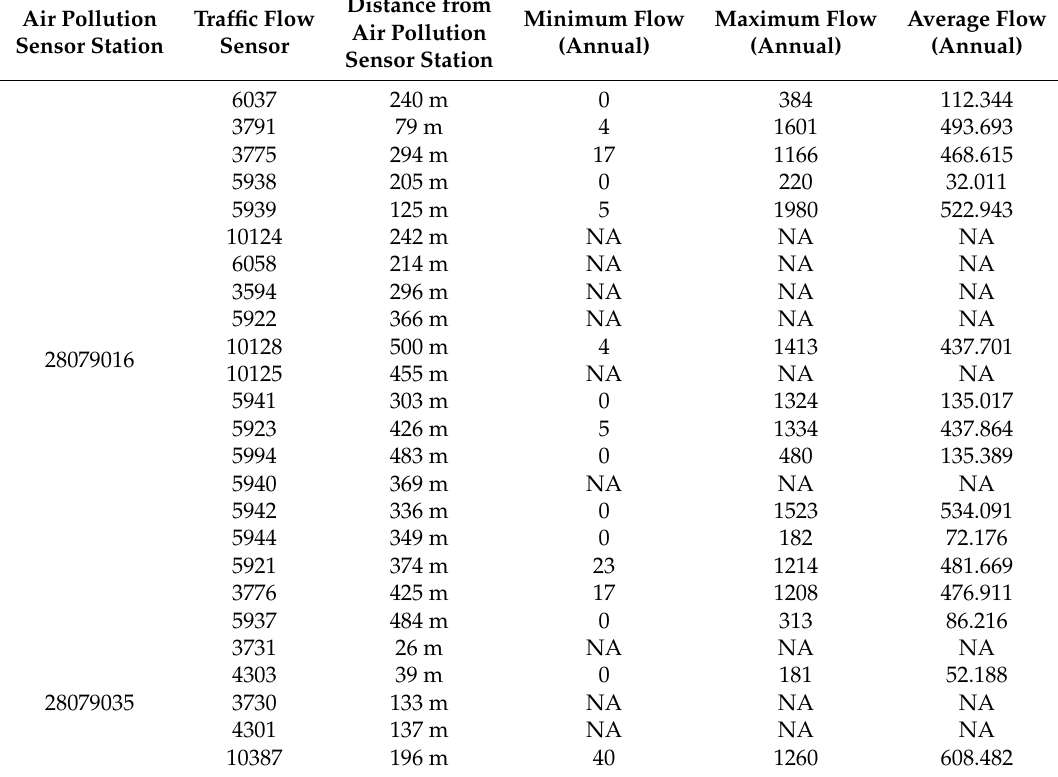
Table 2. Traffic flow sensors’